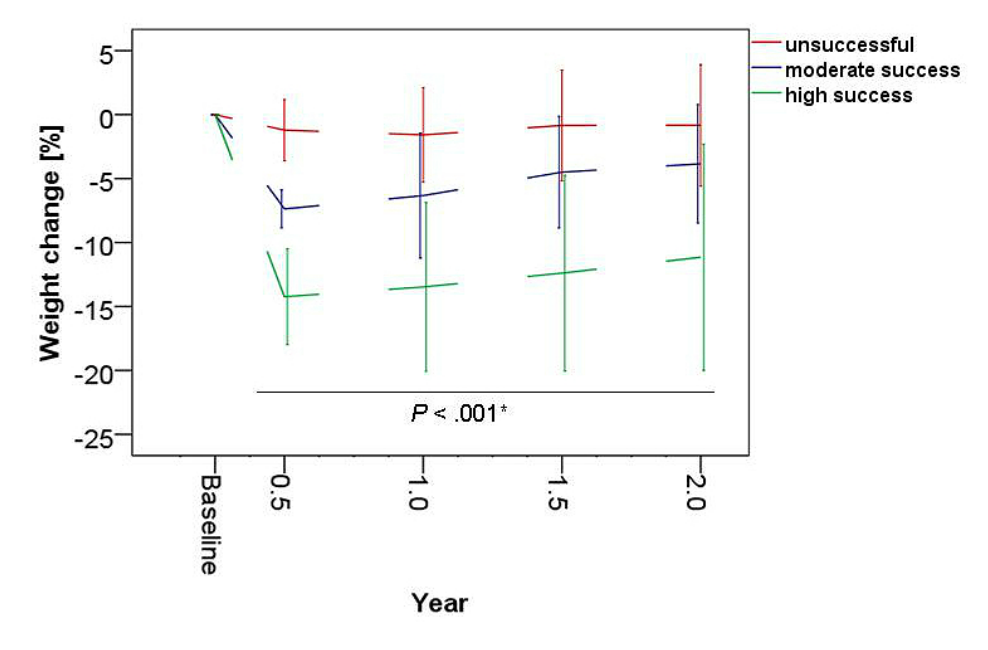
Figure 8. Development of percentage weight loss in the success groups compared to baseline. Weight maintenance during the follow-up period (1, 1.5, and 2 years after the first dietary protocol) of the unsuccessful (<5% weight loss), moderate success (5%-9.9% weight loss), and high success ( ≥ 10% weight loss) groups of the study sample. * = significant difference among the 3 subgroups (Kruskal-Wallis 1-way